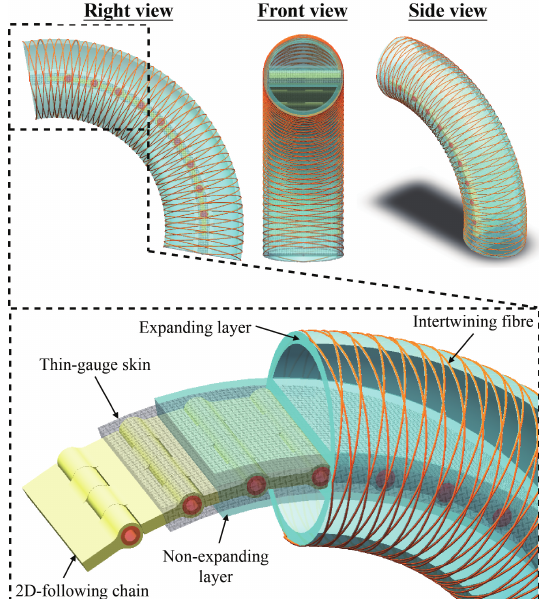
Figure 1. Conceptual diagram of a smart soft actuator with anisotropic soft and rigid